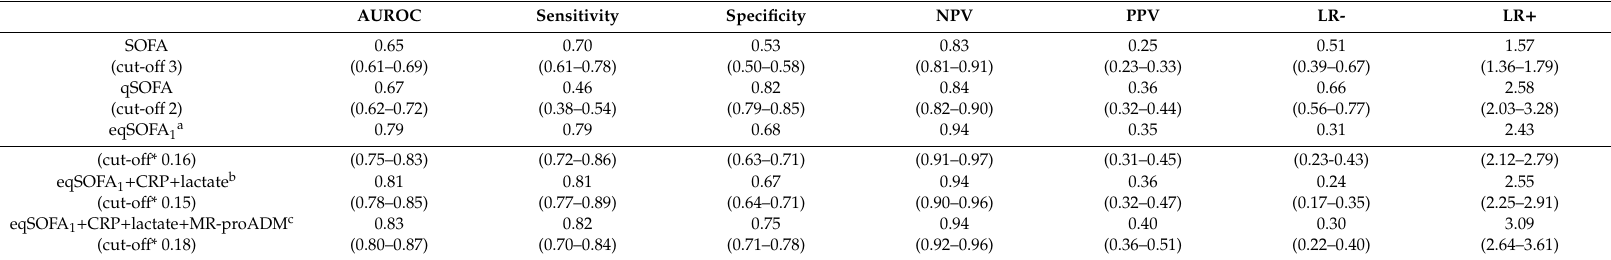
Table 2. Group 1: performance of the quick sepsis-related organ failure assessment (qSOFA), Model 1, Model 2, and Model